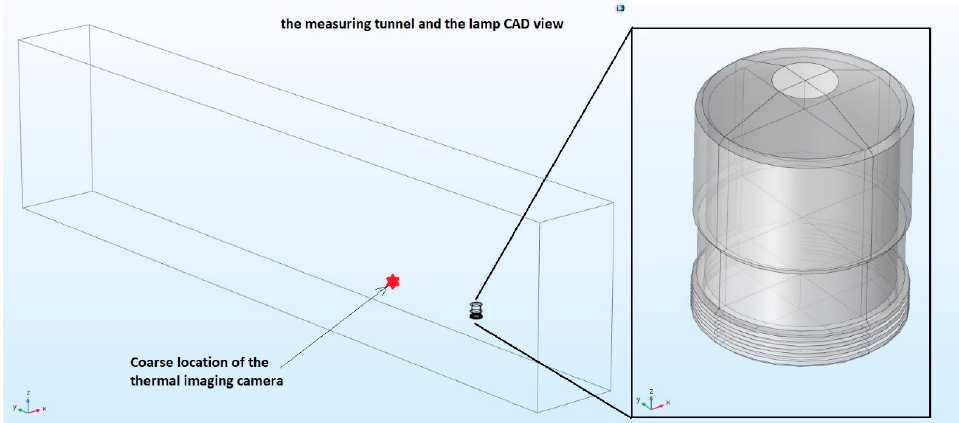
Figure 1. A CAD drawing of the computational domain depicting the rectangular tunnel with the lamp and the lamps enlarged view (to the right).